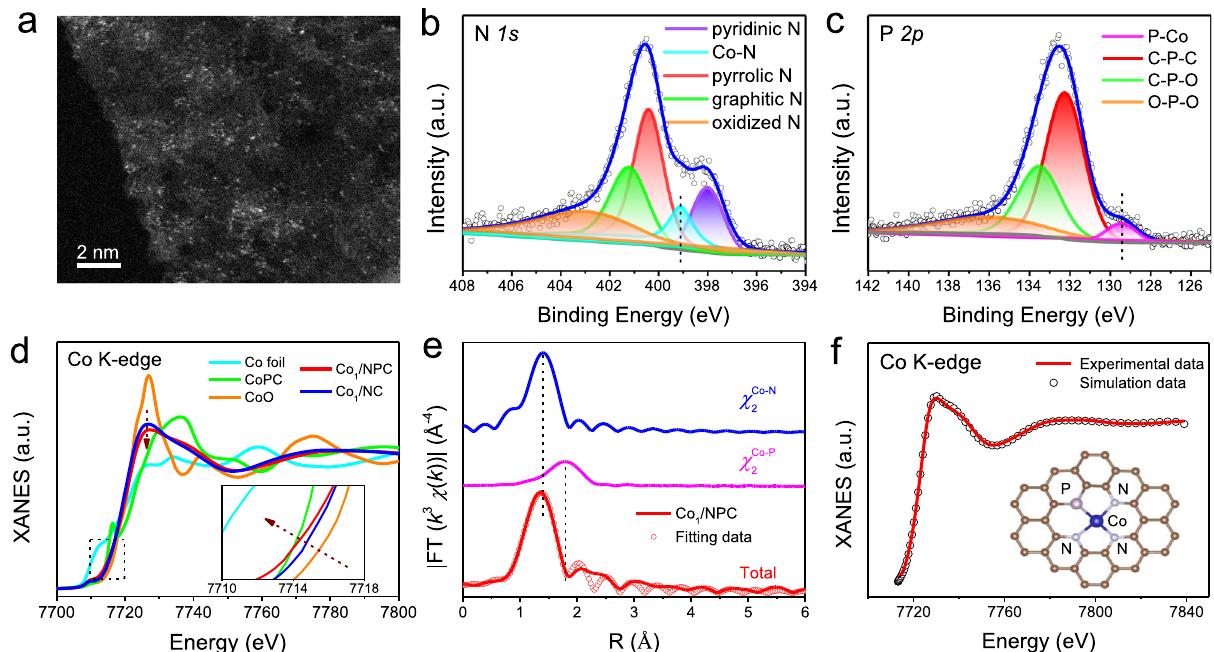
Fig. 1 Structural Characterizations of Co 1 /NPC. a AC HAADF-STEM image of Co 1 /NPC. b N 1 s and c P 2 p XPS spectra of Co 1 /NPC. d Co K-edge XANES spectra. e k 3 -weight FT-EXAFS fi tting curves of Co 1 /NPC. Curves from top to bottom are the Co-N, Co-P backscattering pathways and fi tting total signal (red circle) superimposed on the experimental signal (red line). f The experimental XANES curve in comparison with the calculated XANES data of Co 1 - N 3 P 1 site in Co 1 /NPC sample. Inset: the schematic atomic structure of Co 1 /NPC derived from the EXAFS